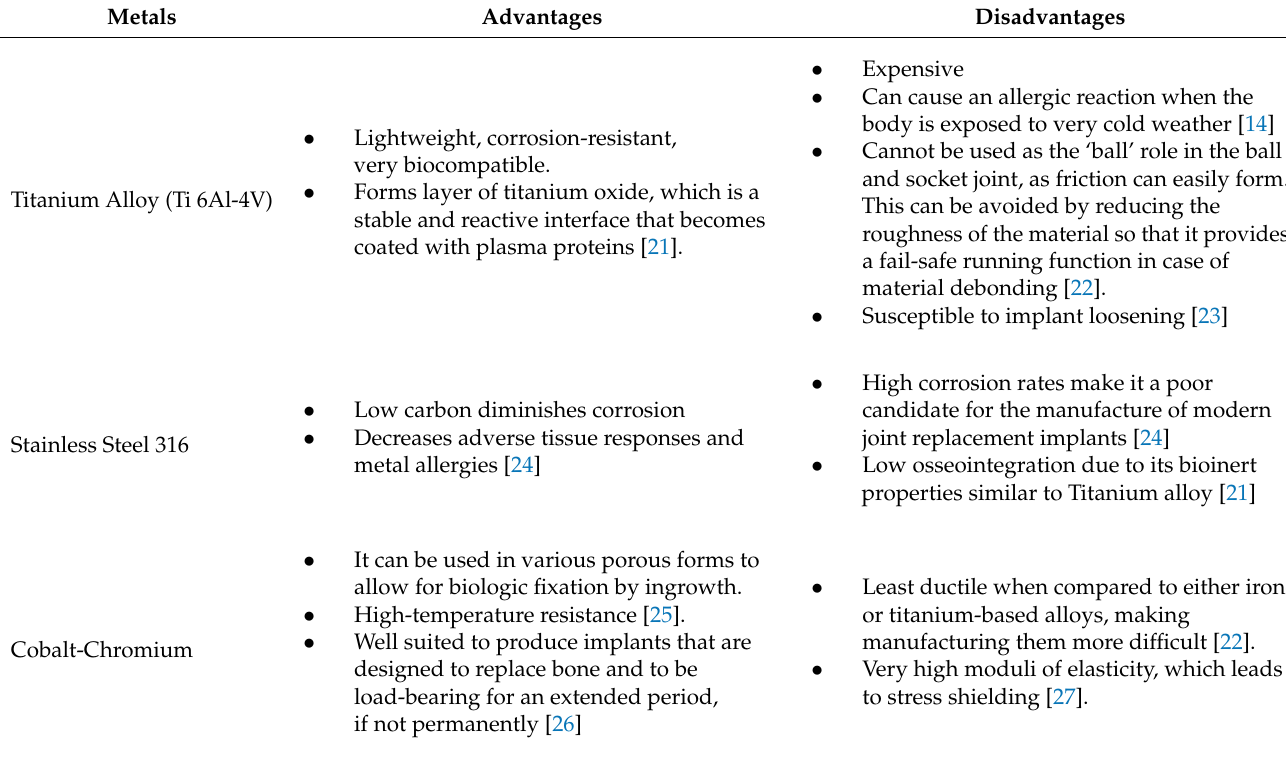
Table 1. Characteristics and Limitations of Current Metallic